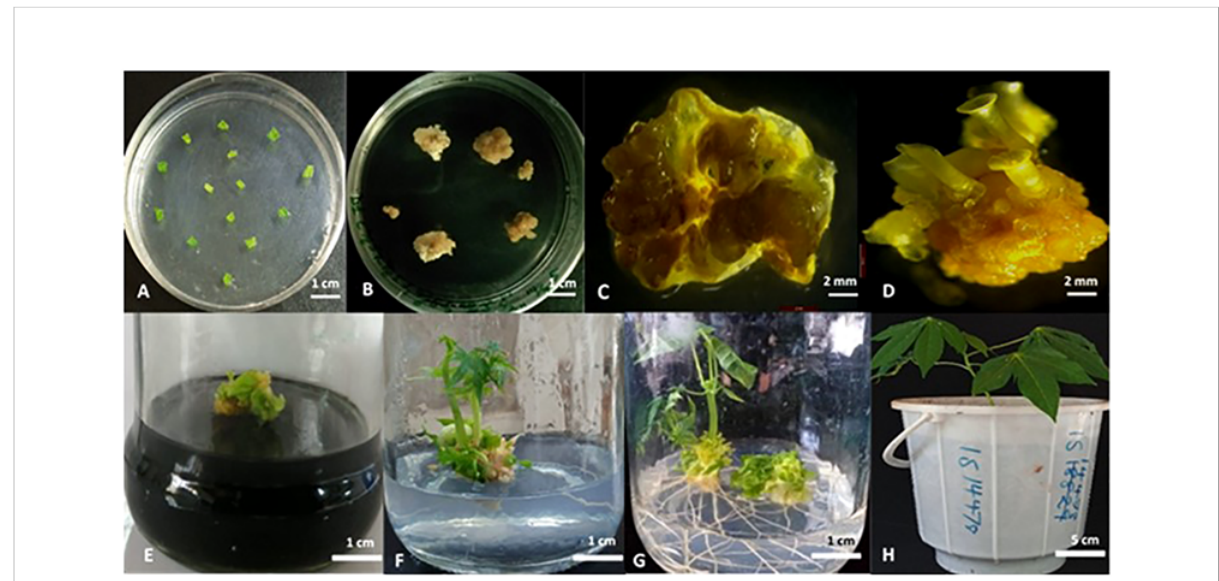
FIGURE 1 Cas9/gRNA Agrobacterium -mediated cassava transformation and recovery of transgenic cassava plants. (A) Co-cultivation of immature leaf lobes with Agrobacterium harboring the DNA construct; (B) Agrobacterium -infected explants in callus induction media under selection; (C) Non-transformed leaf explant in selection medium; (D) Mature callus with the cotyledonary embryos; (E) Desiccation of shoots in activated charcoal (0.8%); (F) Rooting in hormone free MS media; (G) Plantlets after 12 days in rooting media; (H) Putatively transformed cassava hardened in glasshouse. Scale: 1 cm (A, B, E-G) , 2 mm (C, D) , and 5 cm (H)